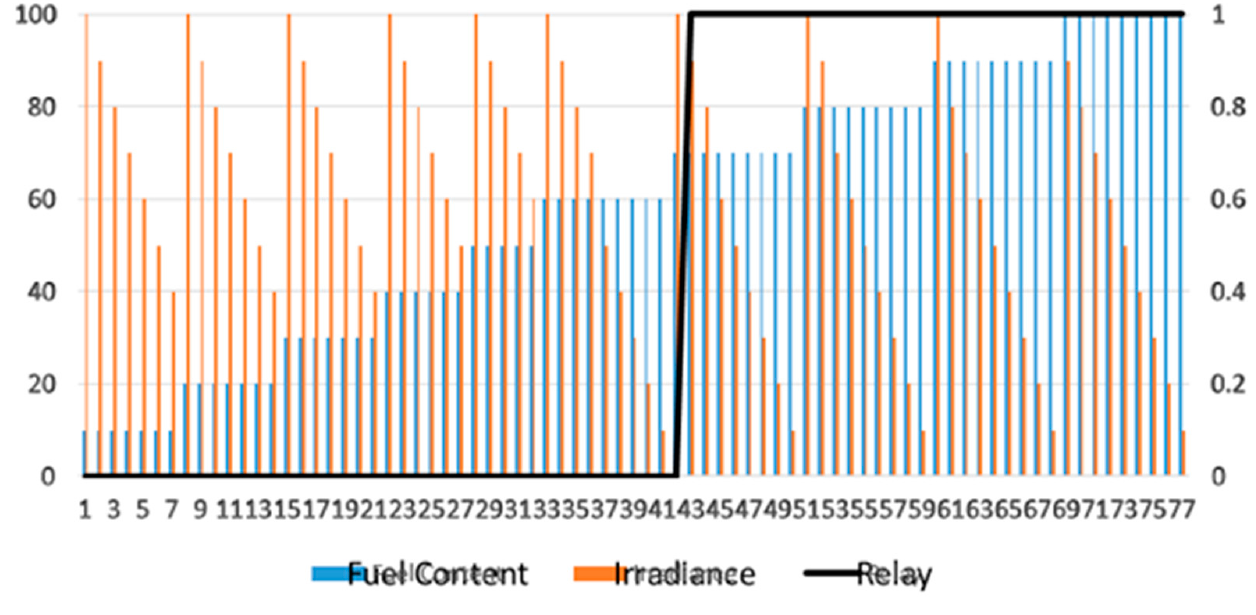
Figure 22. Data for the ANFIS 2.